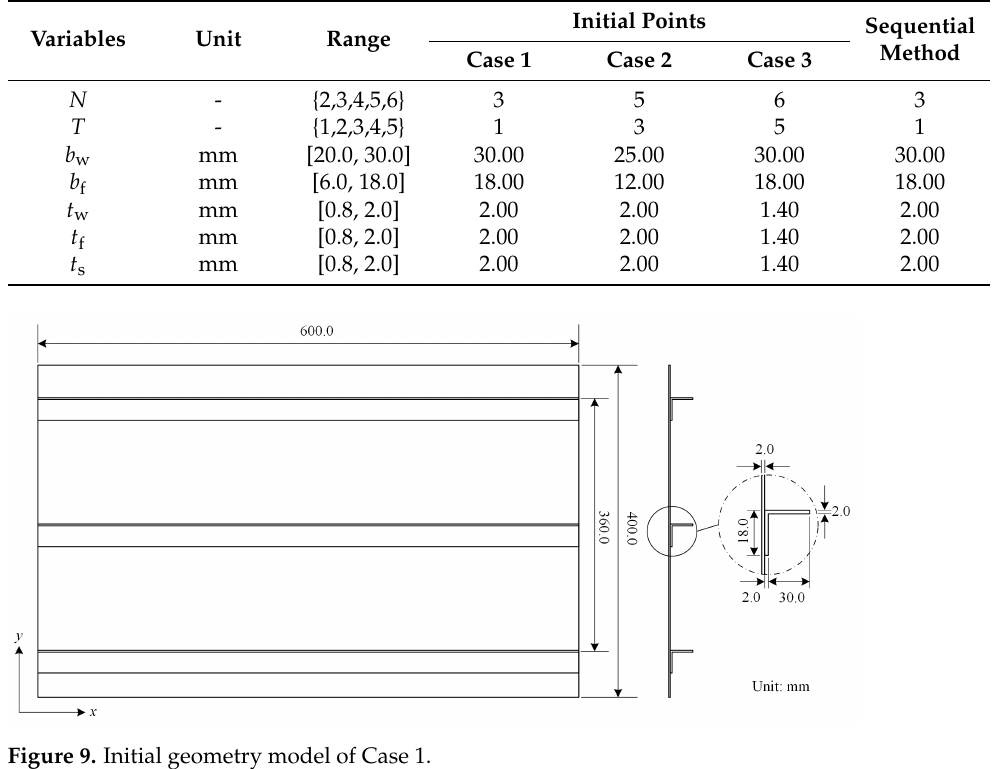
Table 3. Variables range and initial value.